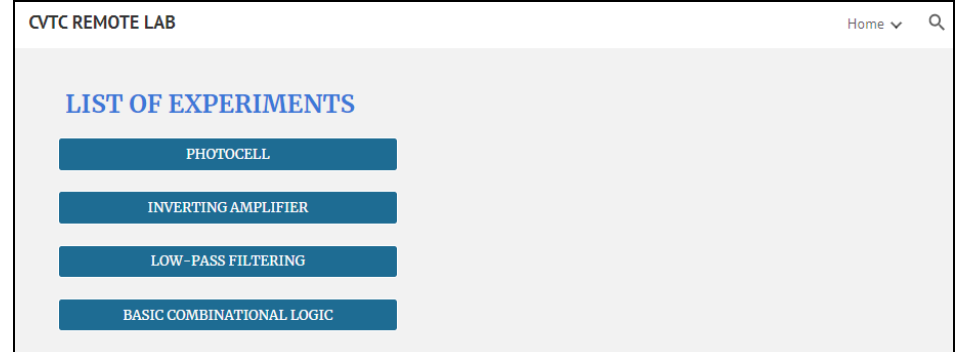
Figure 16. The Laboratory Home Webpage.